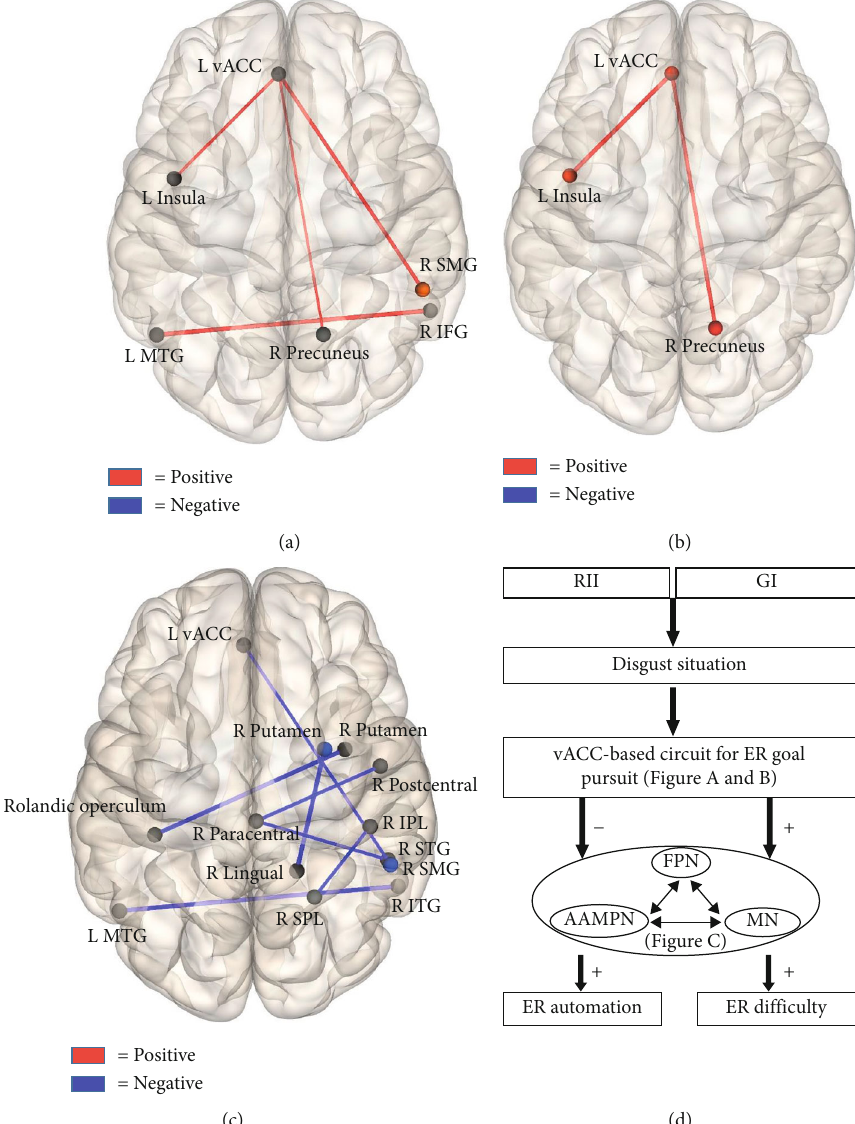
Figure 6: Functional connectivity patterns of the contrasts GI (a) and RII (b) versus watching condition and the contrast RII versus GI (c). The connections (edges) between ROIs marked in red mean that GI or RII relative to watching shows greater FC strength, and those marked in blue mean that RII relative to GI shows weaker FC intensity. ITG: inferior temporal gyri; MTG: middle temporal gyri; SMG: supramarginal gyri; STG: superior temporal gyri; IPL: inferior parietal lobule; SPL: superior parietal lobule; SMG: supramarginal gyri. (d) The dynamic architecture of the FC mechanisms underlying GI and RII. FPN: frontoparietal network; AAMPN: aversive anticipation and motor planning network; MN: memory network; ER: emotion